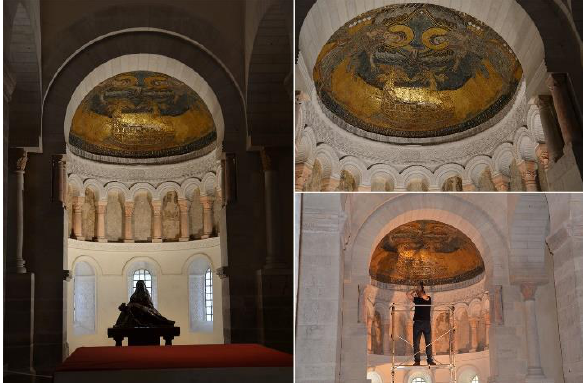
Figure 1 The mosaic of Germigny-des-prés © Line Van